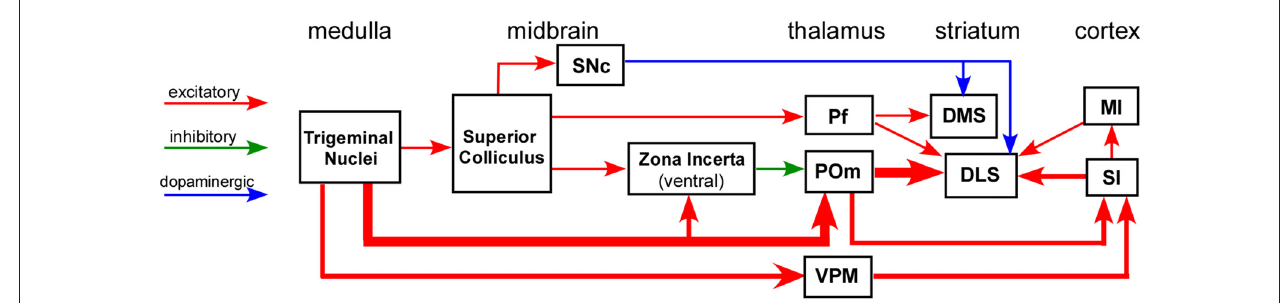
FIGURE 2 | Circuit diagram illustrating multiple neuronal pathways for conveying sensory inputs to the striatum. The thick afferent and efferent connections of the POm indicate the most direct route for transmitting somesthetic information to the DLS. Abbreviations: DMS, dorsomedial striatum; DLS, dorsolateral striatum; MI, primary motor cortex; Pf, parafascicular nucleus; POm, posteromedial nucleus; SI, primary somatosensory cortex; SNc, substantia nigra pars compacta; VPM, ventroposteromedial nucleus. Adapted from Watson et al. (2015).